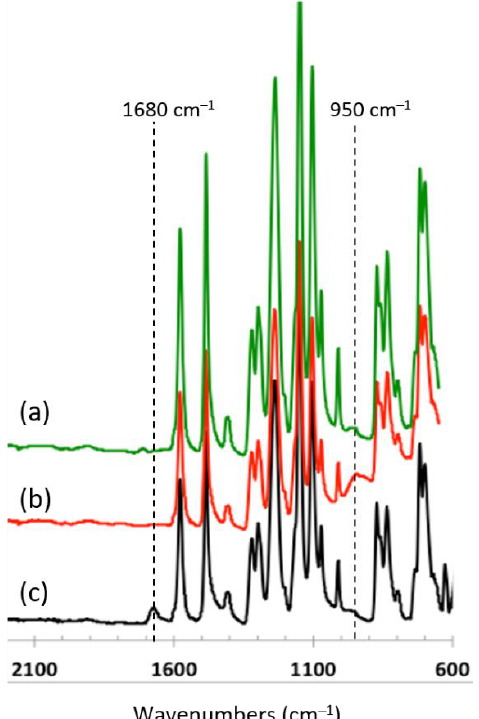
Figure 11. ATR-FTIR spectra of ( a ) TMA (green)-infiltrated PES fibres, ( b ) Al 2 O 3 -infiltrated PES fibres (red), and ( c ) uncoated PES fibres (black).